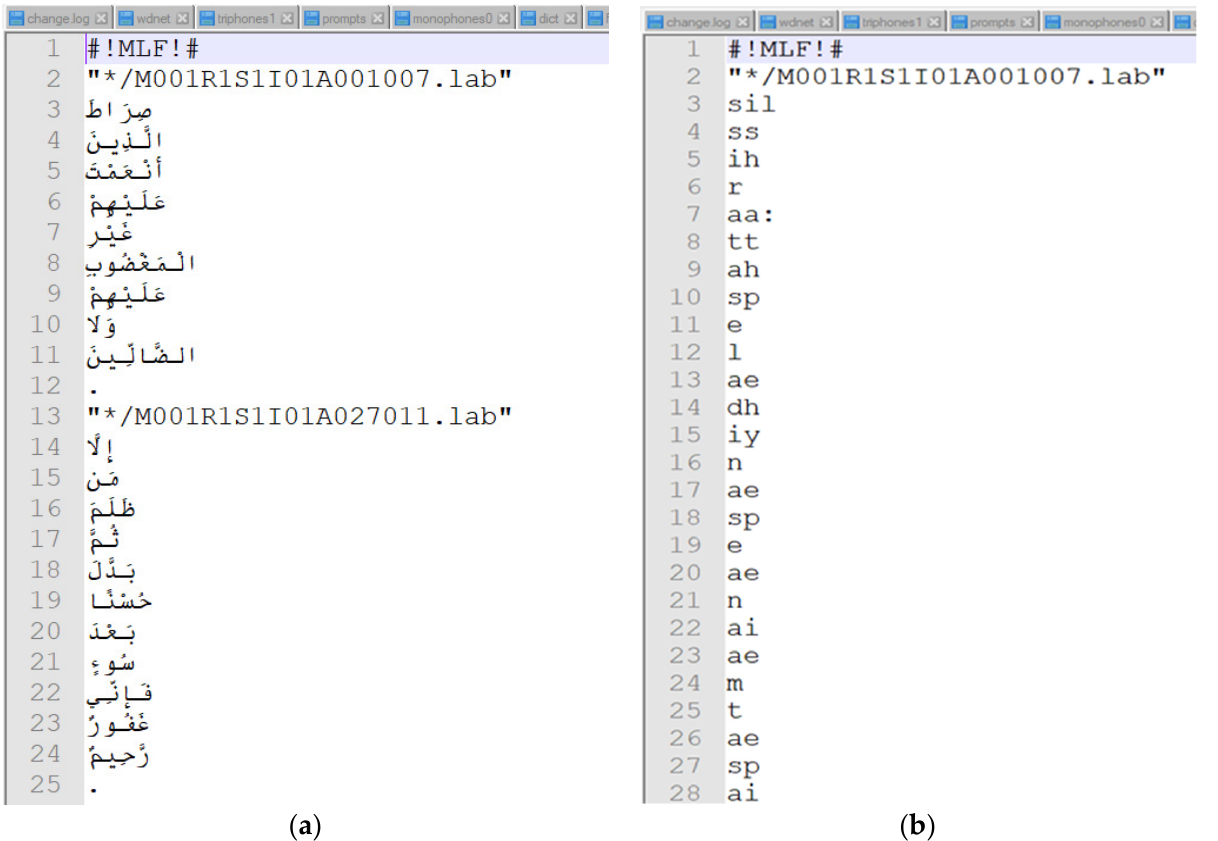
Figure 6. Sample of Level Transcriptions, ( a ) words Level Transcriptions, and ( b ) Phone Level Transcriptions.